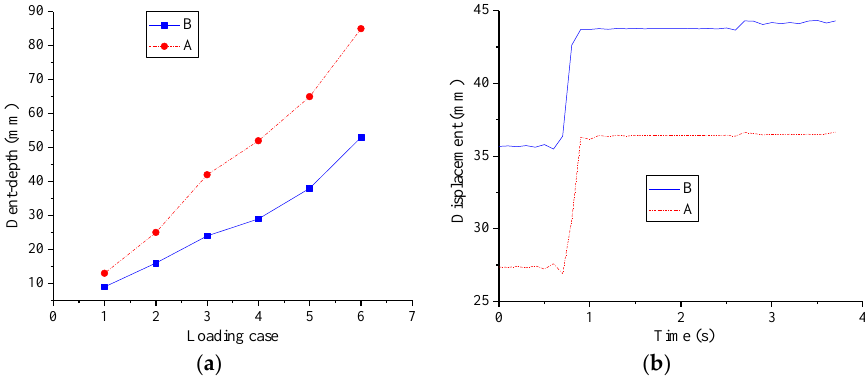
Figure 5. ( a ) Dent-depth at the impact position; and ( b ) the displacement time-history of the impact position’s back surface under case G6.